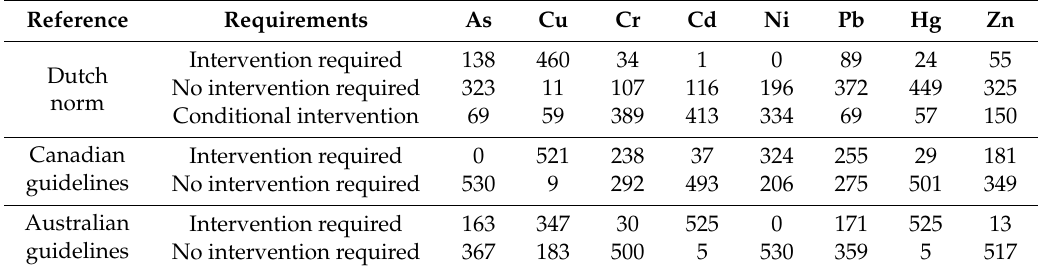
Table 5. Results of the Dutch, Australian, and Canadian soil quality reference guidelines application to 530 Chilean